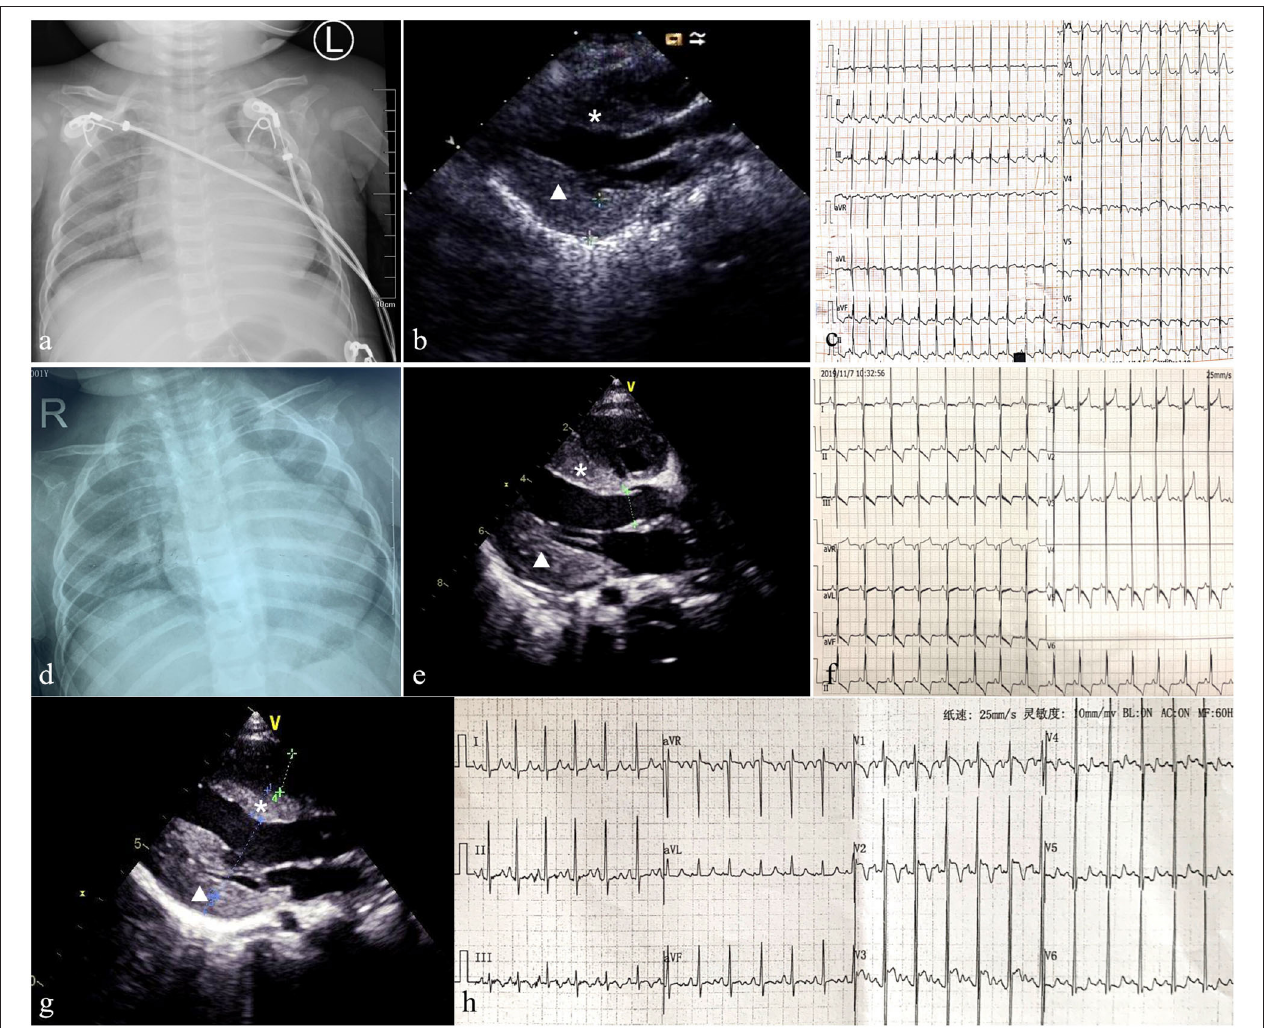
FIGURE 1 | Patient 1: Chest X-ray showed an enlarged heart (the cardiothoracic ratio reached about 0.65) (a) and echocardiography indicated hypertrophic non-obstructive cardiomyopathy (b) . ECG showed sinus tachycardia, short PR interval, biventricular hypertrophy, and multi-lead ST segment changes (c) . Follow-up for 8 months, chest X-ray indicated the CTR was 0.65 (d) . Echocardiography showed the thickness of IVS and LVPW were 9 and 11mm, respectively, with no outflow obstruction, and LVEF was 60% (e) . ECG revealed multiple lead ST-T changes and left ventricular hypertrophy (f) . Patient 2: Echocardiography showed the thickness of interventricular septum (IVS) and left ventricular posterior wall (LVPW) were 9 and 10mm, respectively (g) . ECG revealed left ventricular hypertrophy and multiple lead ST-T changes (h) . The asterisk represents IVS and triangle represents